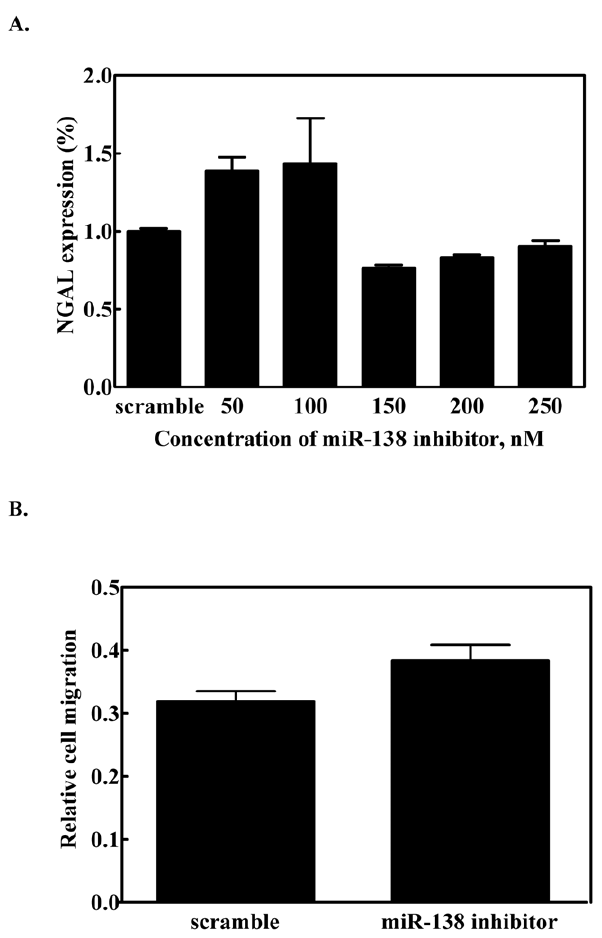
Figure 4. Effect of miR-138 inhibitor on NGAL expression. (A) NGAL mRNA expression levels, and (B) cell migration assay for miR-138- inhibitor transfected MCF-7 cells. Error bars indicate p . 0.05.